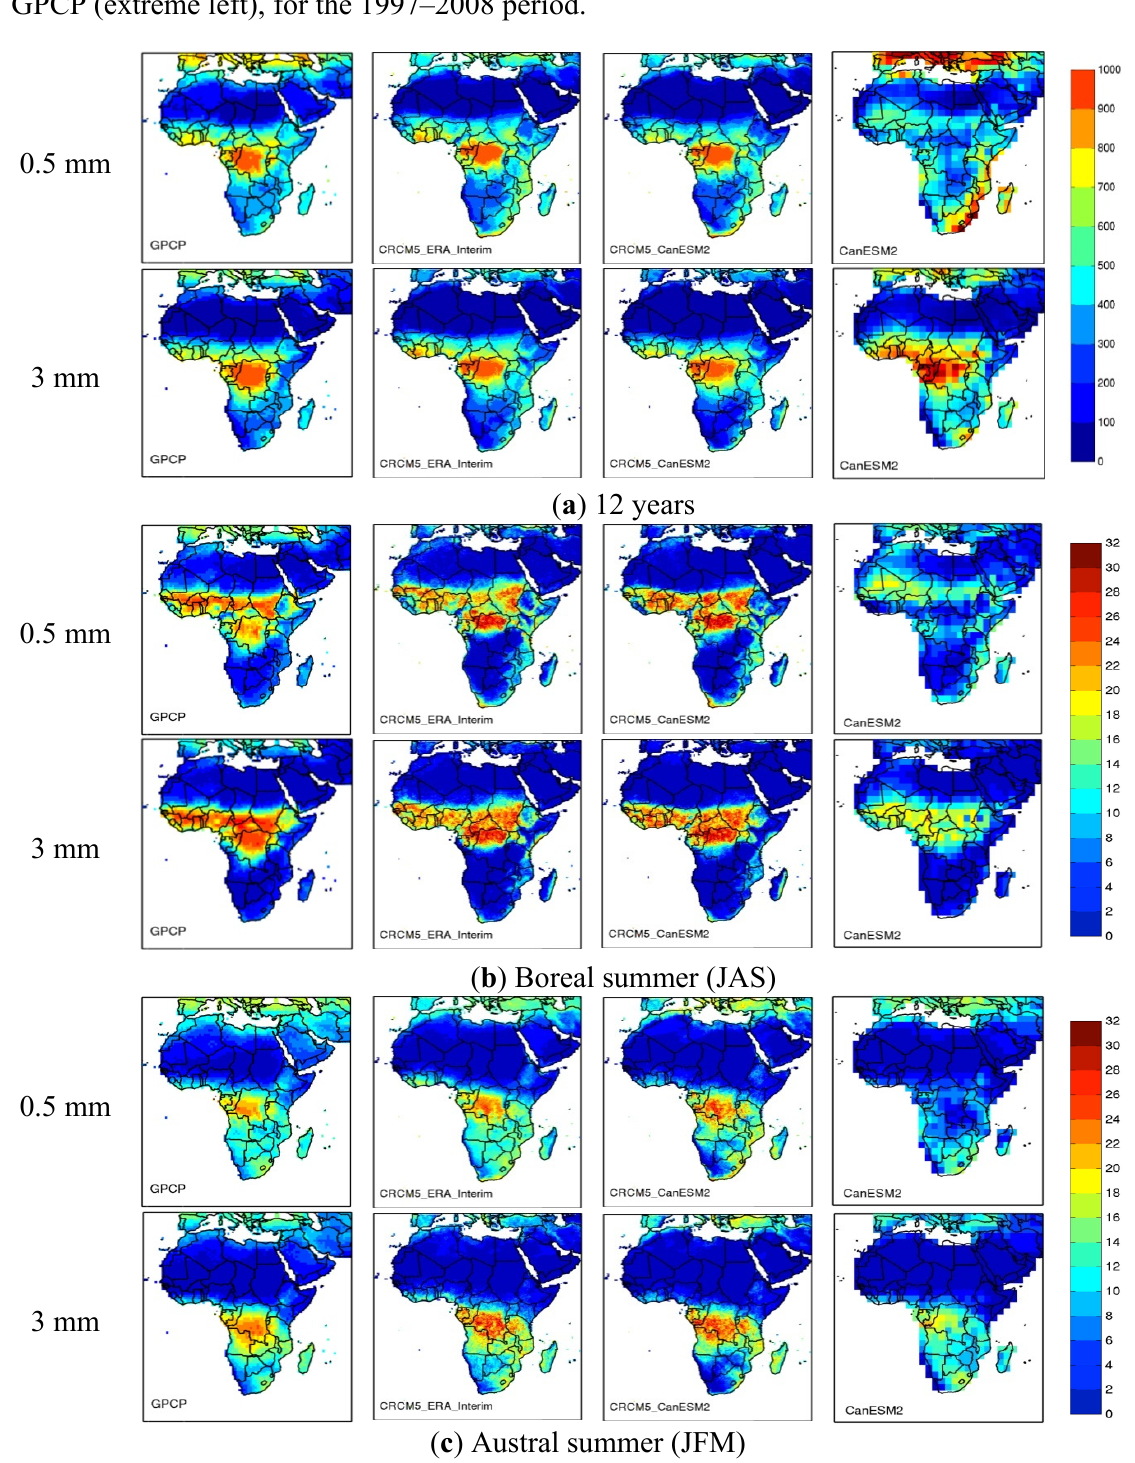
Figure 3. Number of dry spells at 0.5 mm (top) and 3 mm (bottom) thresholds for the ( a ) total 12 years, ( b ) boreal summer and ( c ) austral summer period for CRCM5 driven by ERA-Interim (middle left), and CanESM2 (middle right), CanESM2 (extreme right) and GPCP (extreme left), for the 1997–2008